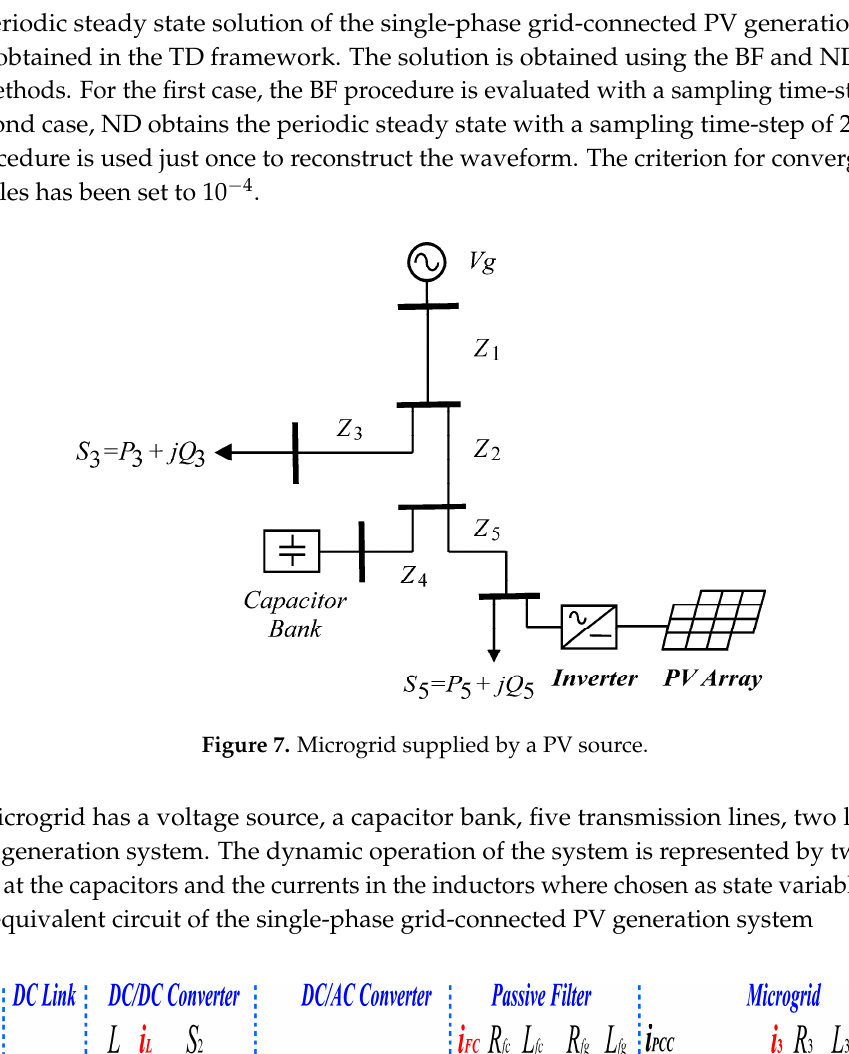
Figure 8. Equivalent circuit of the microgrid supplied by a PV source (state variables are highlighted in red).